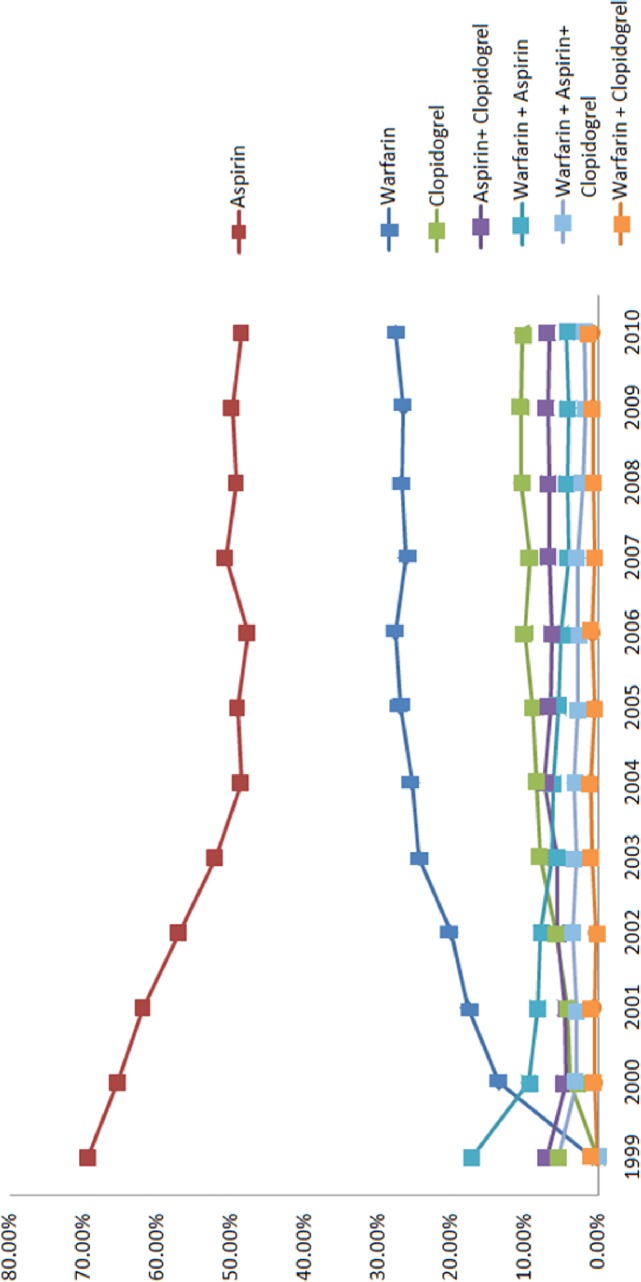
Trends of various antiplatelet and anticoagulant agent usages during the study period, 1999–2010.